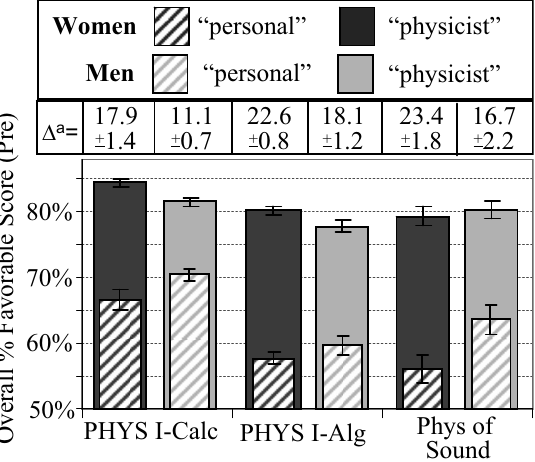
FIG. 7. “Personal” (cid:1) striped bars (cid:2) and “physicist” (cid:1) solid bars (cid:2) pre scores by gender and current course. Error bars indicate the stan- dard error on the mean. Note the change in scale. a Average of the difference (cid:1) (cid:1) (cid:2) between “personal” and “physicists” pre scores for each student in that group and (cid:1) one standard error on the